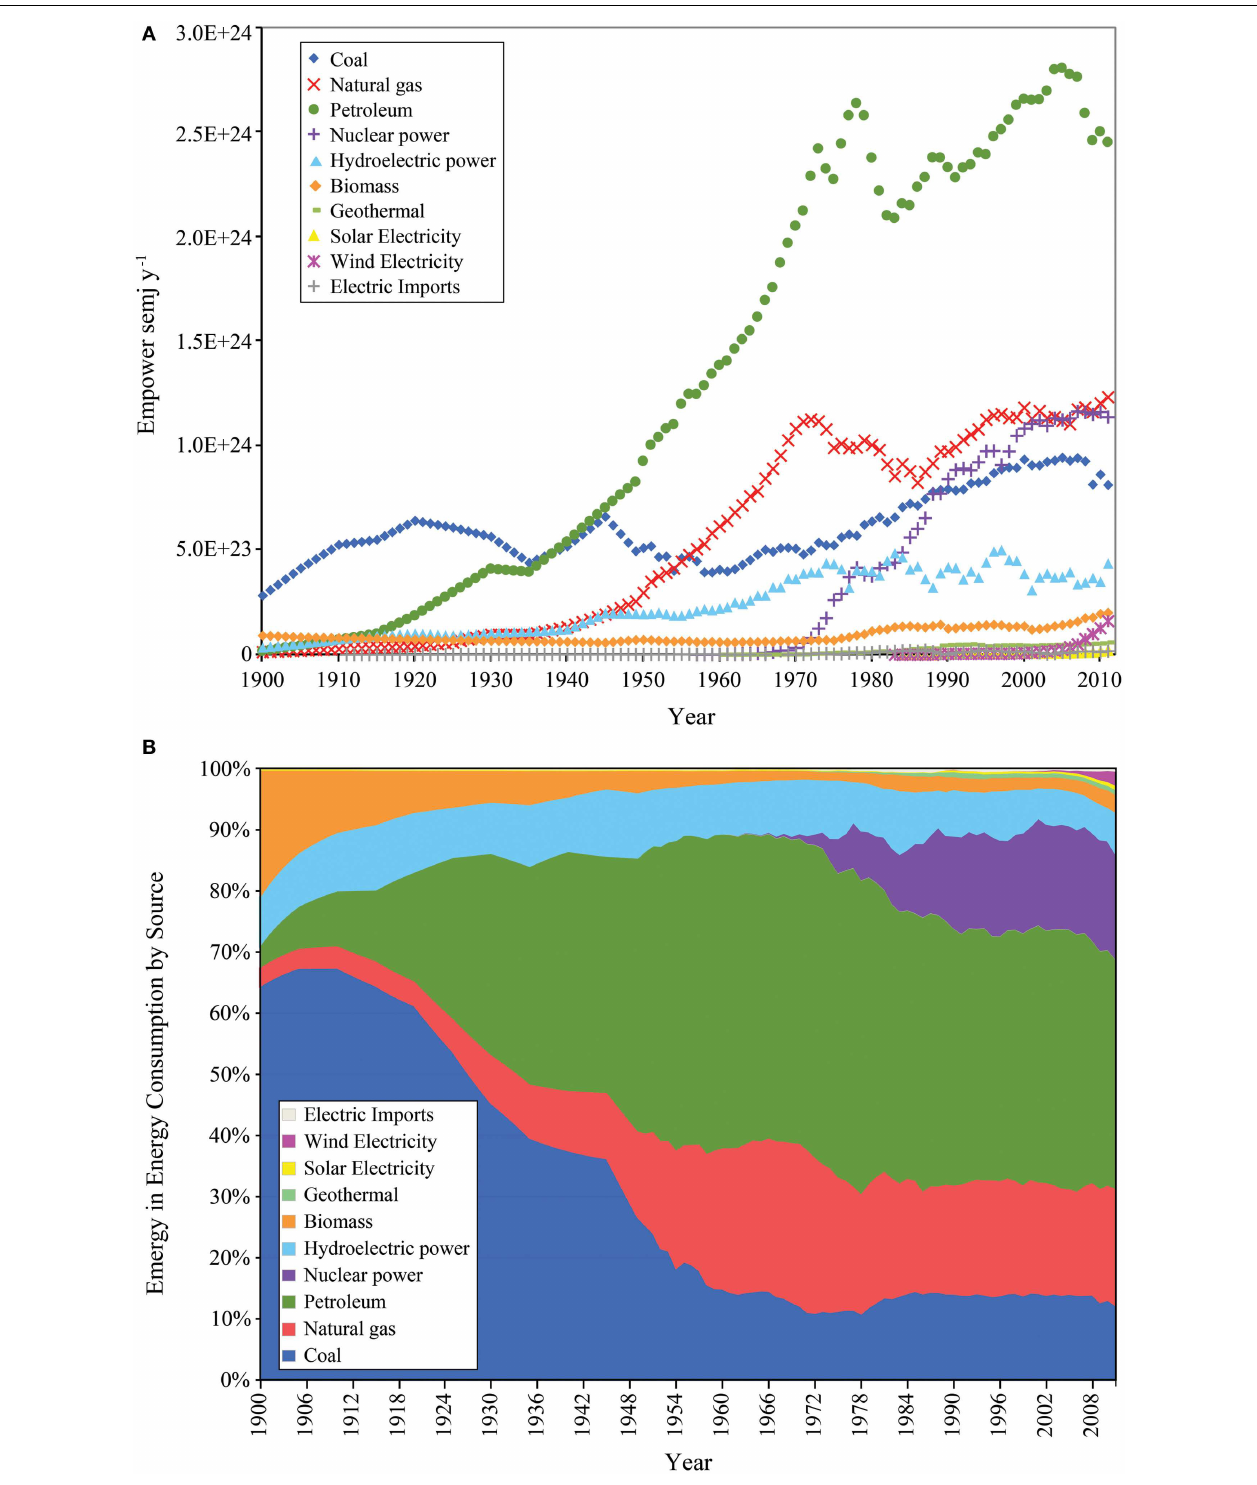
FIGURE 6 |Temporal patterns of the components of the energy consumed in the United States from 1900 to 2011 are shown . (A) Time series of values for the major classes of energy inflows; (B) structure of the major classes of energy input as percent composition.